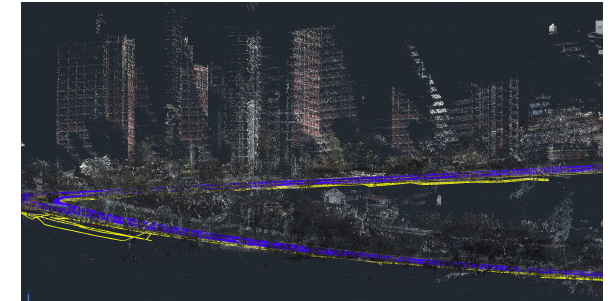
Figure 5. Example of output in CAD format for extracted utilities (yellow lines) and captured point